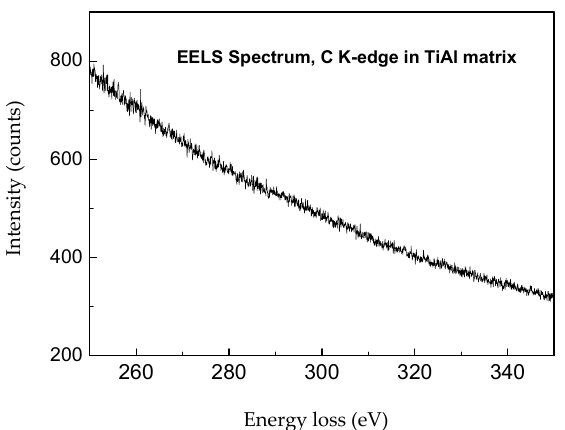
Figure 12. EELS spectrum in the sublayer adjacent to the substrate, K Edge C (284 eV).